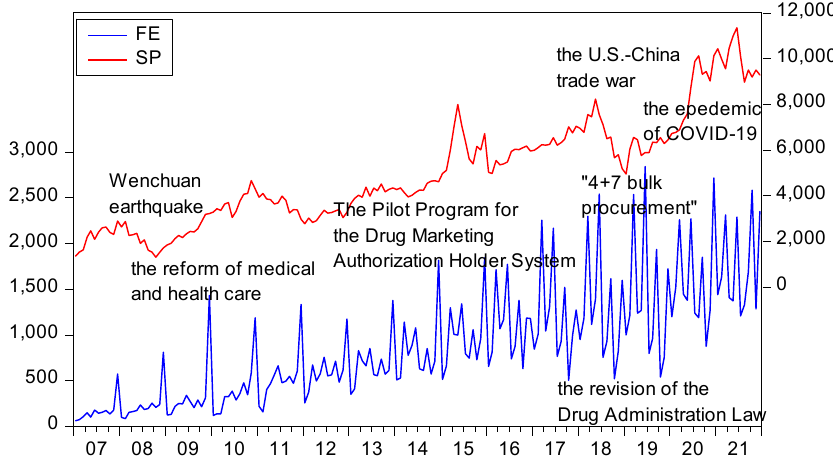
Figure 1. The trends of FE and SP. From Table 1, the average values of FE and SP are 874.995 and 5013.098, respectively. The skewness of FE is 0.974, and the skewness of SP is 0.630, indicating that both data sets have asymmetry. The kurtosis of FE was 3.480, representing a fat-tailed feature, while the kurtosis of SP is 2.743, showing a flat distribution. On the side, the results of the test of Jarque–Bera show that the two series are non-normally distributed at the 1% level. Hence, the traditional Granger causality test is not applicable. In this article, the bootstrap sub-sample rolling-window method and the RB method are used to increase the reliability of the results and avoid the possible non-normal distribution between FE and SP